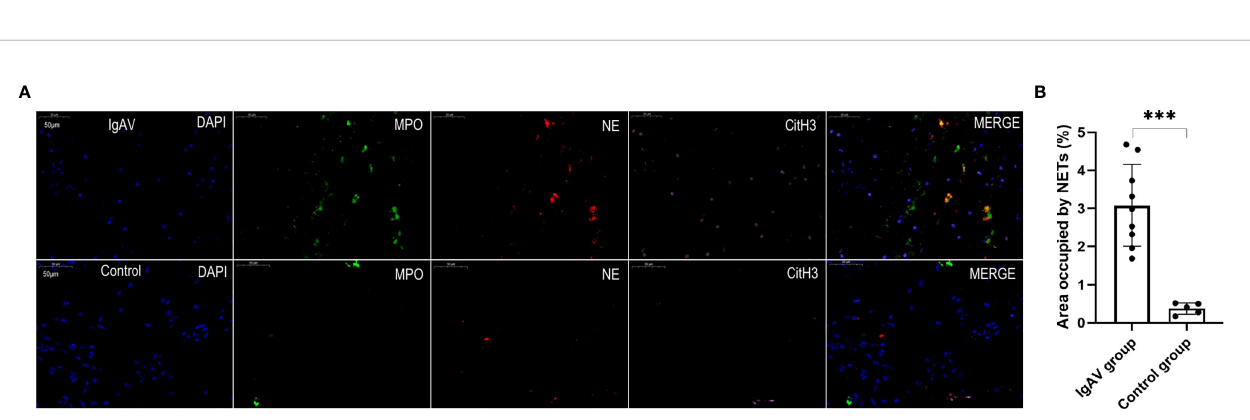
FIGURE 5 | (A) Staining of intestinal tissue in order to visualize NETs. NETs were present in the villi mucosal and submucosal tissues of the duodenum of an IgAV patient but absent in healthy control tissue. The micrographs are from representative a IgAV patient and a healthy control. (B) Area occupied by NETs in intestinal tissue, as determined by image analysis. ***P <